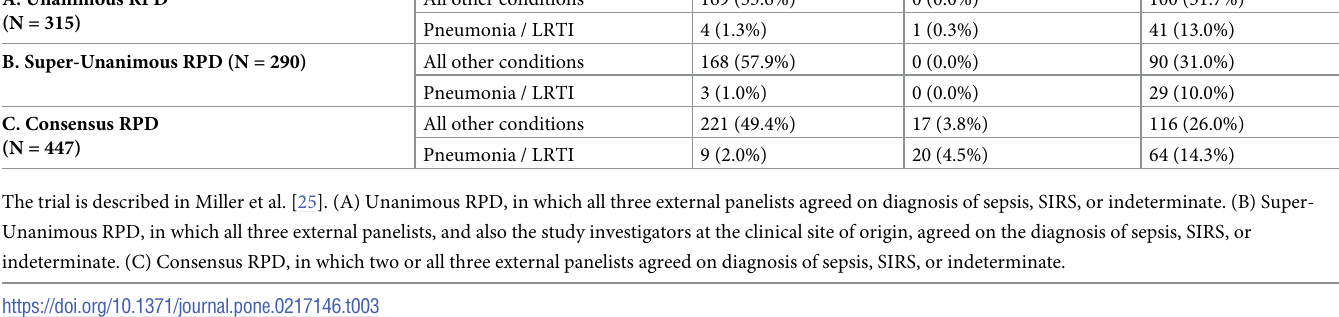
the actual clinical trial data. Similarly, with the injection of 7.5% misclassifications, the simula- tion contained as much noise as was observed for the Forced group, as shown in Table 2. The comparison between simulated (predicted) and observed diagnostic test performance is shown in Table 2. Of the 447 patients in the trial, 93 were diagnosed by consensus RPD as having pneumonia or lower respiratory tract infections (LRTI). With respect to the secondary diagnosis of sepsis vs. SIRS, very high levels of disagreement (uncertainty) by the expert panelists were found for this subset of patients. In only 45/93 (48%) of these cases did all three external panelists agree on the diagnosis of sepsis or SIRS. A further indication of the difficulty of diagnosing